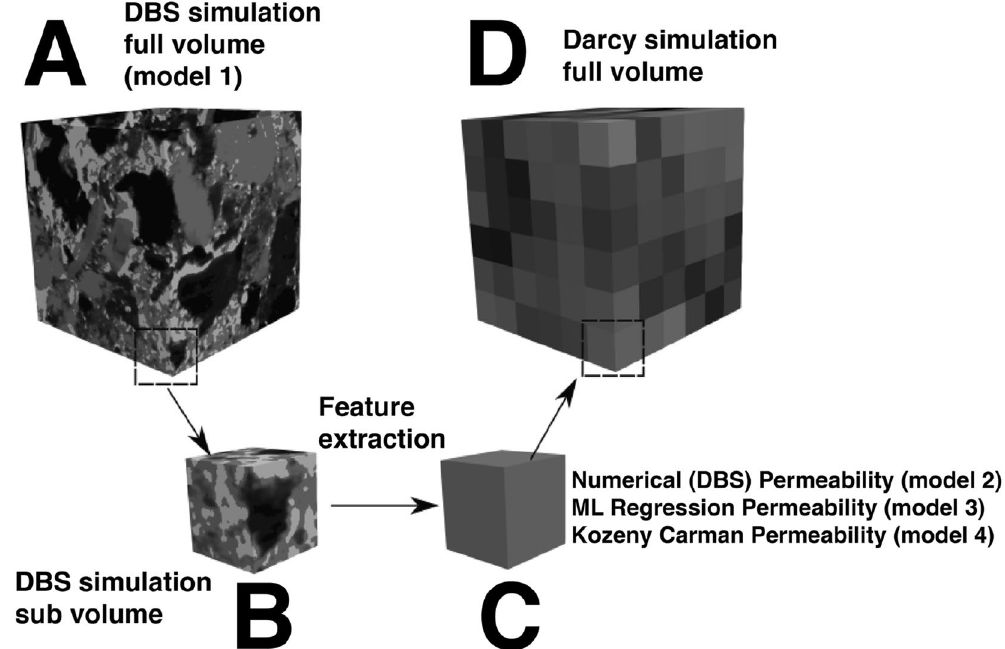
Figure 5. The upscaling workflow: A 360 3 voxel block ( A ) is cut into 60 3 sub-volumes ( B ). The permeability for each sub-volume is then solved using DBS for numerical upscaling, the features extracted for machine learning upscaling, and the porosity calculated for Kozeny–Carman upscaling. The upscaled permeability for each model is then assigned to each upscaling Darcy block ( C ), and then the Darcy permeability is solved on the upscaled volume ( D ). Images in this figure were rendered using Paraview 49